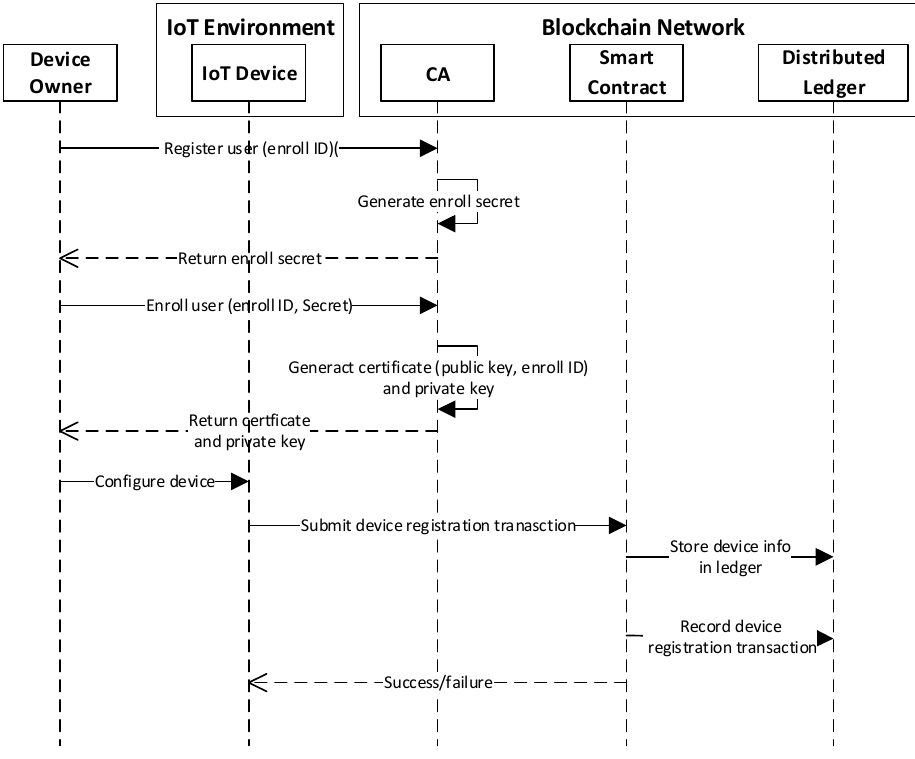
Figure 5. The operation process of user enrolment and device registration.